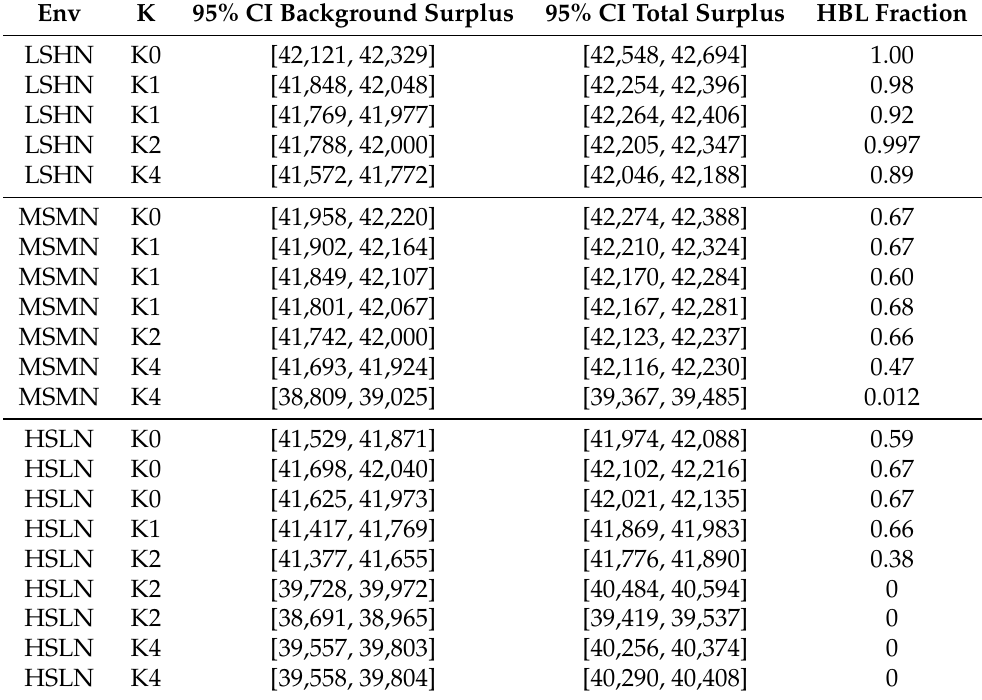
Table A12. Equilibria for games where the exploiter does not spoof. Each row of the table describes one equilibrium found with its corresponding background surplus, total surplus and HBL adoption rate. The results reported are based on at least 20,000 simulation